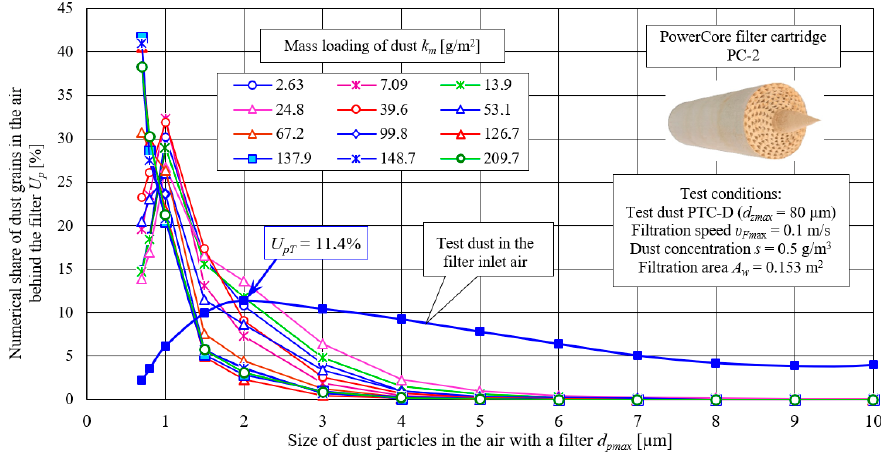
Figure 25. The proportion of U p dust grains in the air upstream and downstream of the PowerCore filter (PC-2) after reaching successive dust absorption coefficients k mPC 2 .